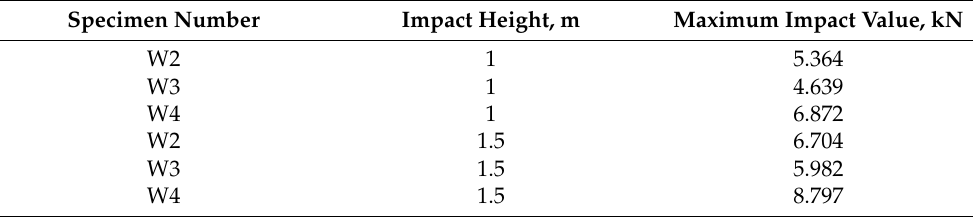
Table 3. Results of maximum impact force